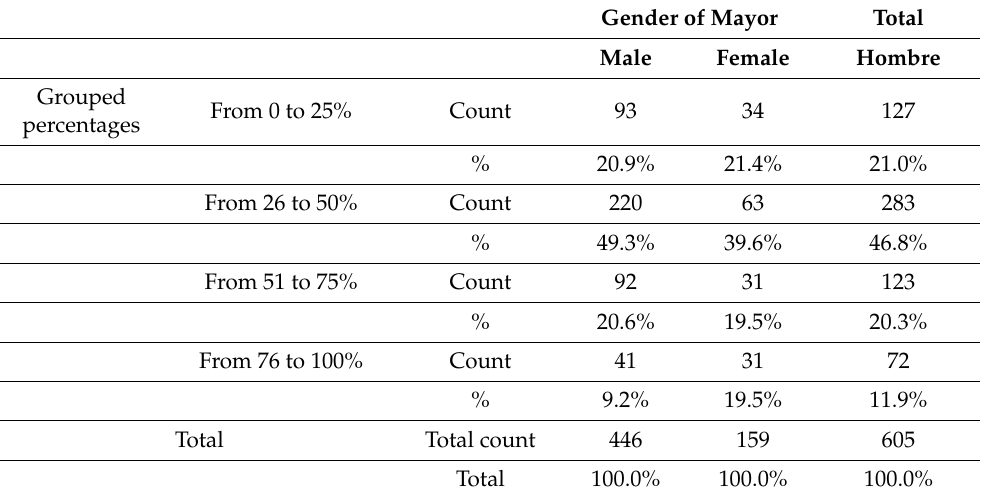
Table 4. Degree of compliance of global indicators cross-referenced with the gender variable.